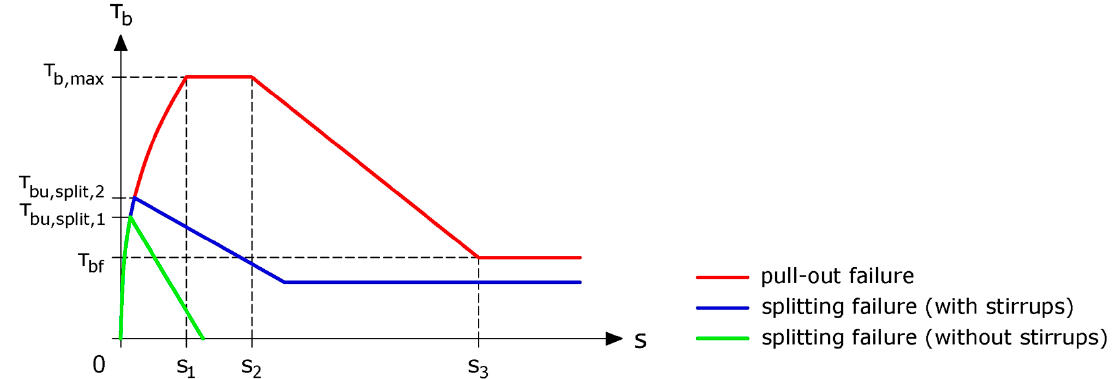
Table 8. Concrete parameters in numerical simulations.